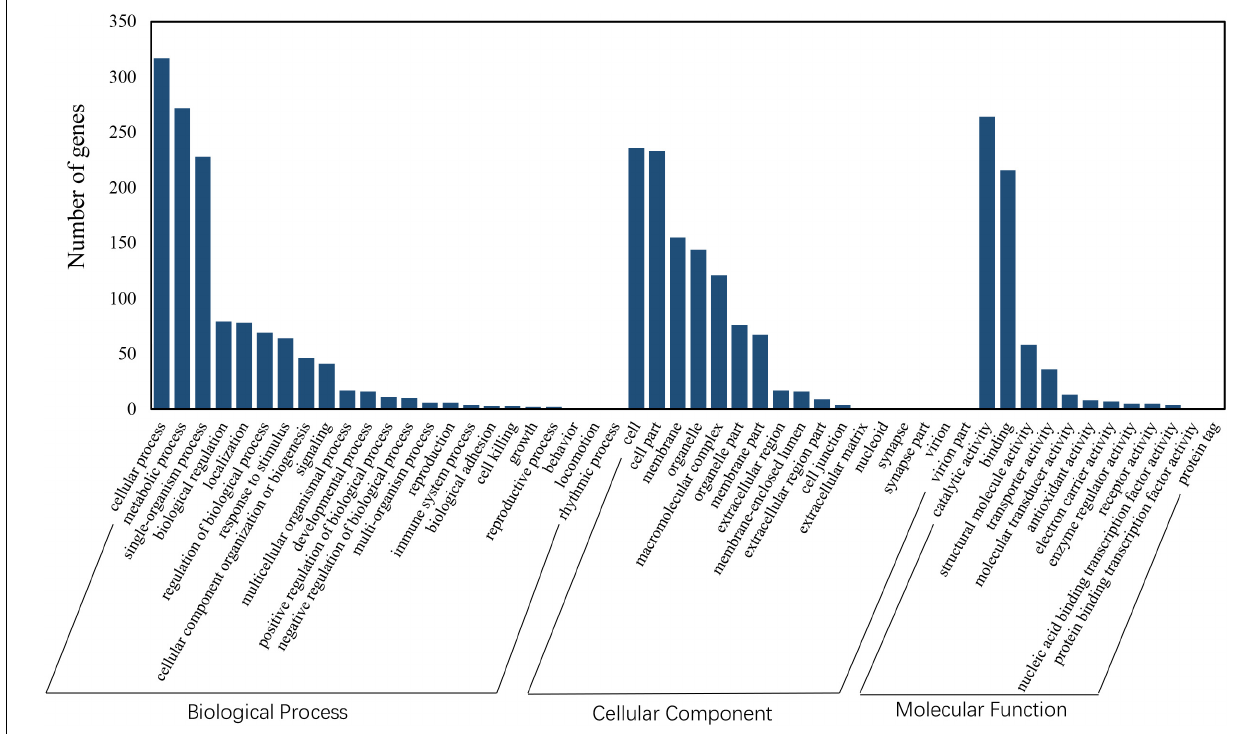
FIGURE 2 | GO enrichment analysis revealed the biological processes most associated with detected DEGs. Based on the GO results, “cellular process,” “metabolic process,” “membrane” and “catalytic activity” were the most enriched GO terms under heat acclimation.